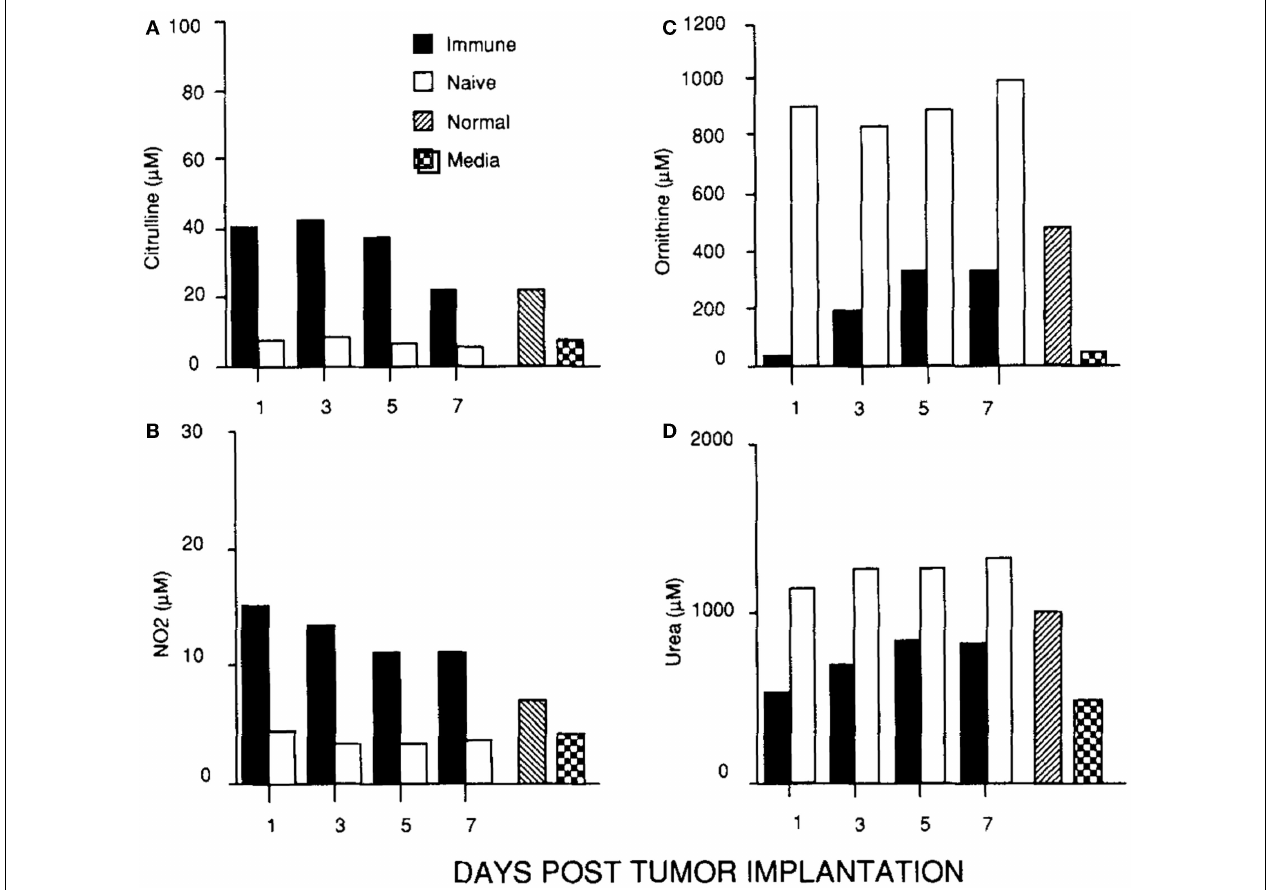
FIGURE 5 | (C, D) Macrophages in a growing tumor (naïve) make growth-promoting ornithine (and urea). (A, B) Macrophages in a rejecting tumor (immune) make killer NO (and citrulline). From Ref. (45). Copyright 1992. The American Association of Immunologists,